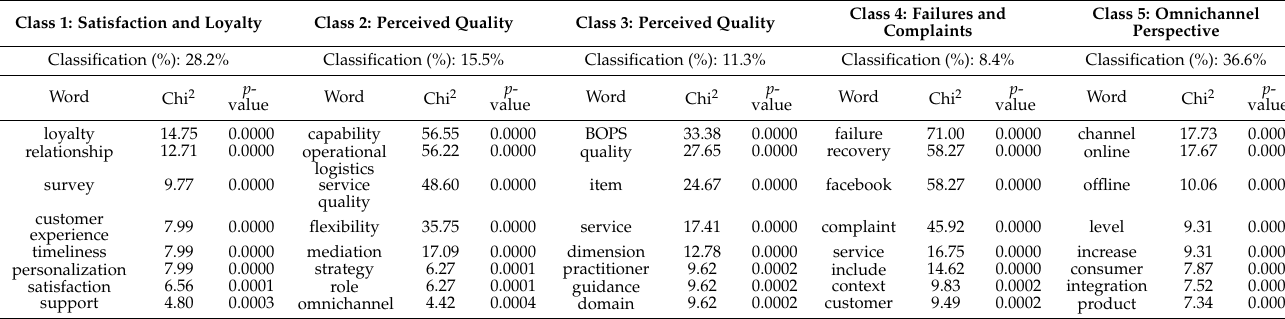
Table 5. Typology analysis: post-purchase